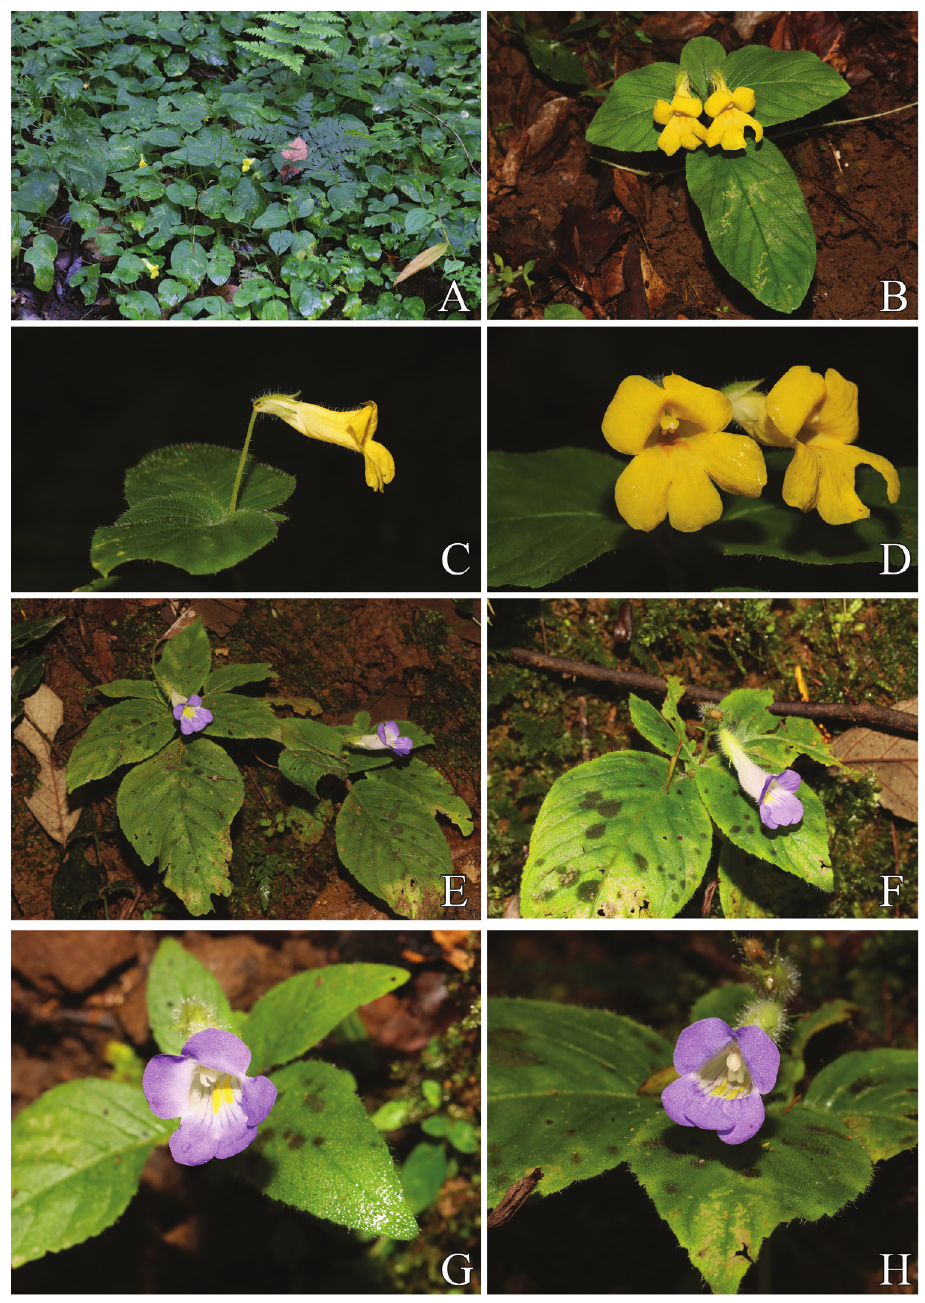
Figure 9. Henckelia xinpingensis Y.H.Tan & Bin Yang, sp. nov. ( A–D ) A, B Habit C flower (side view) D flower (front view); Henckelia pumila (D. Don) A. Dietr. ( E–H ) E, F habit G, H flower (front view). Photographed by H.B.